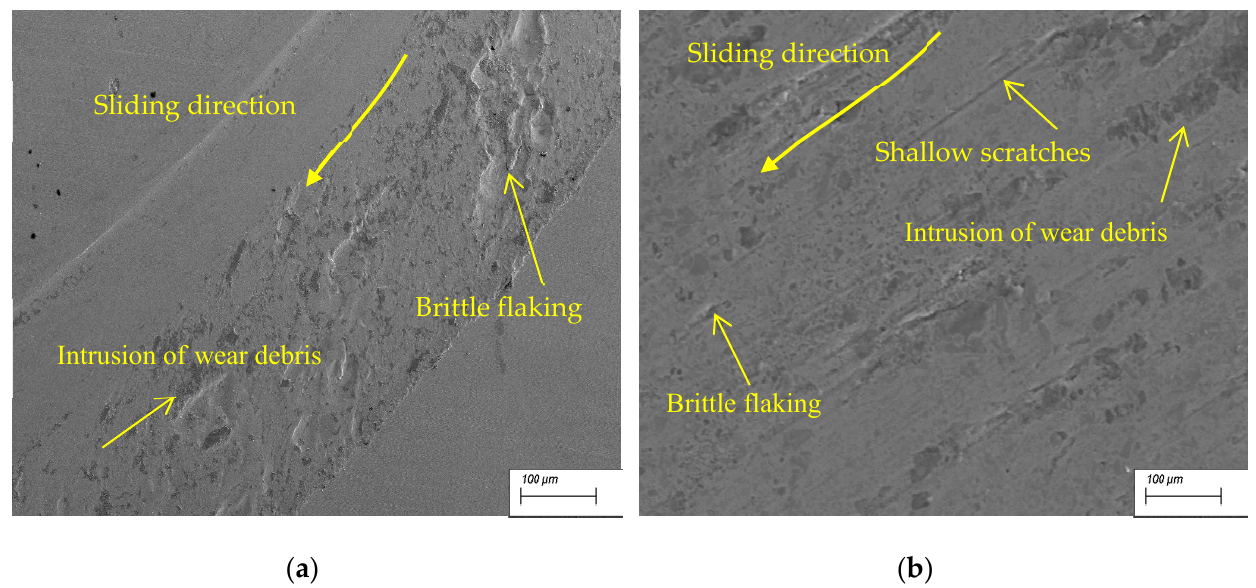
Figure 10. Wear morphology of the cladding layer with or without ultrasonic vibration. ( a ) No ultrasonic vibration; ( b ) 34 kHz ultrasonic vibration.